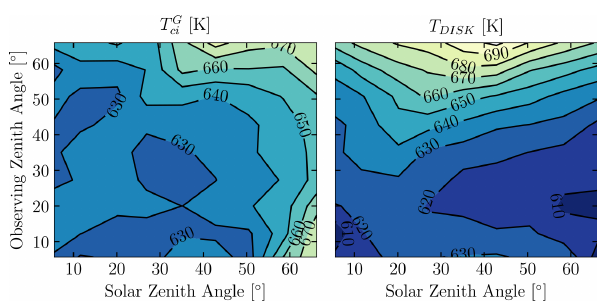
from T DISK , T MSIS , ci Figure 9. Mean T G and T DISK temperatures as a function of SZA ci and OZA for the period of 2–8 November 2018 with 5 ◦ binning in SZA and